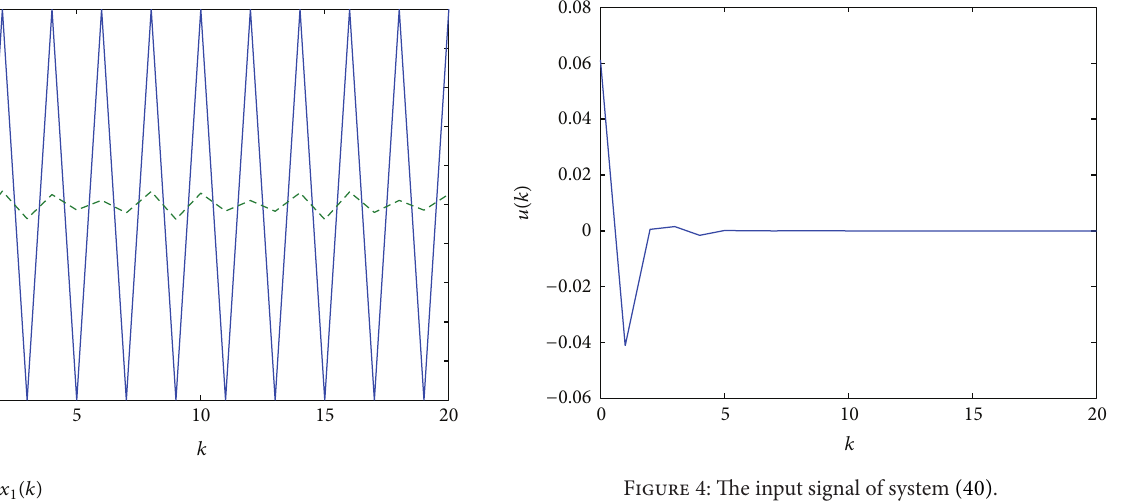
Figure 4: The input signal of system